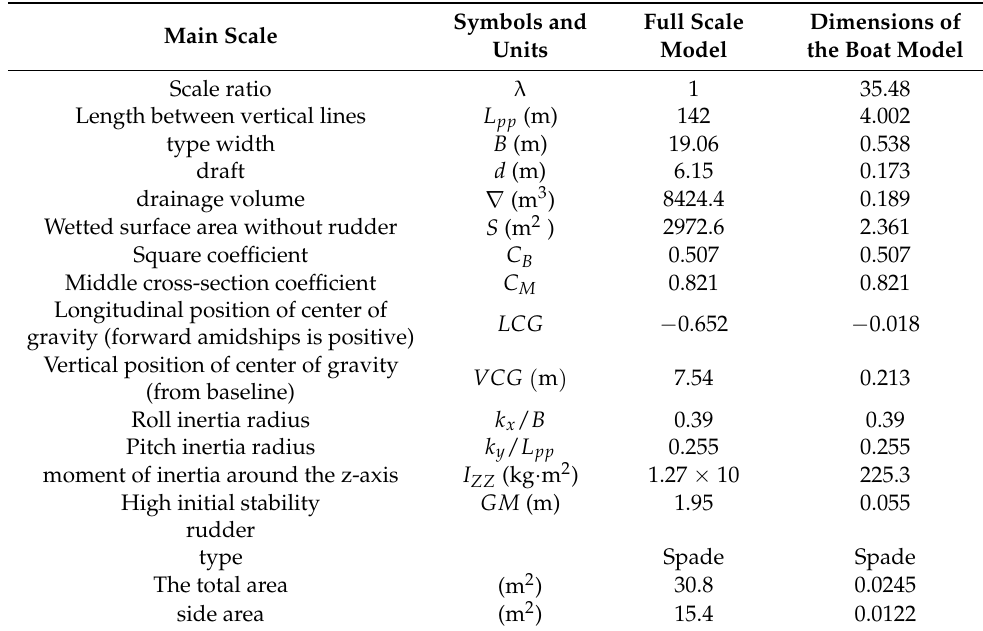
Table 1. Main parameters of the fully attached 5415 ship model. Symbols Main Scale